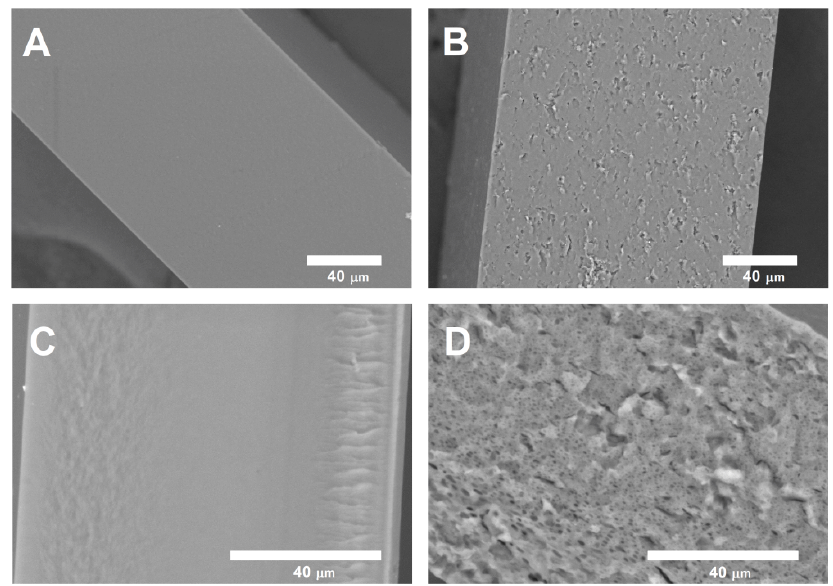
Figure 3. SEM-micrographs of the cross sections of films: ( A ) CS-PVP, ( B ) CS-PVP-G 1%, ( C ) CS- Plu, ( D ) CS-Plu-G 1%. Cross-sectional images show a rough internal structure of composite films associated with intermolecular interactions of the components.